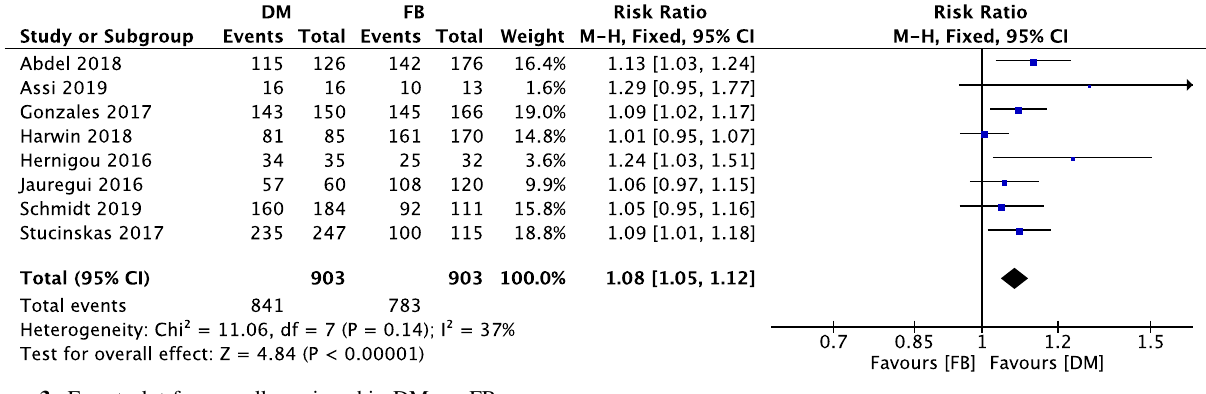
Figure 3. Forest plot for overall survivorship DM vs. FB.